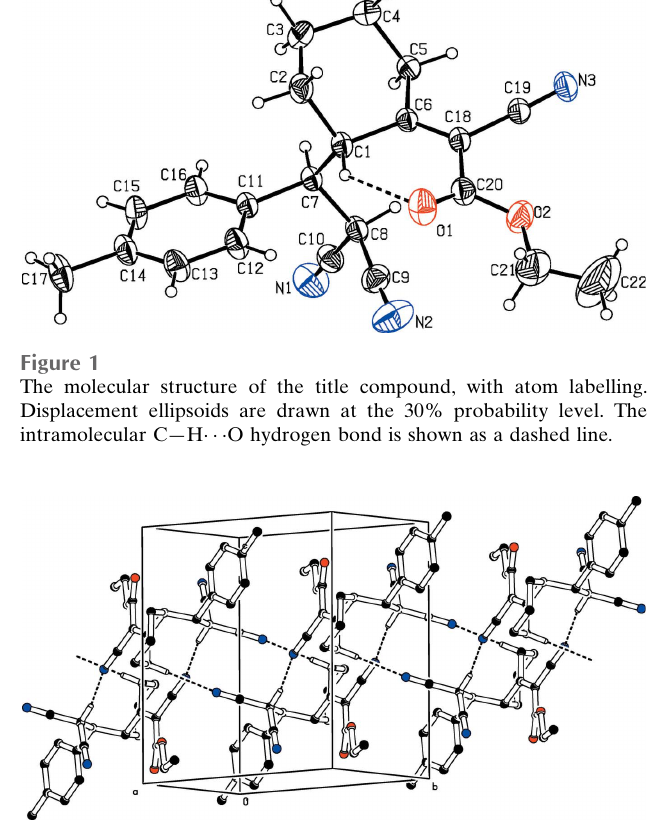
Figure 2 The crystal packing of the title compound viewed down the a axis. The C—H (cid:3)(cid:3)(cid:3) N hydrogen bonds (see Table 1) are shown as dashed lines. For clarity, H atoms not involved in these interactions have been omitted.